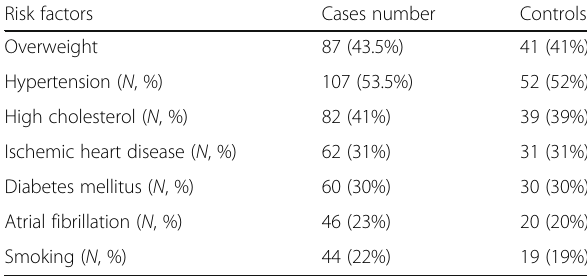
Table 1 vascular risk factors among stroke and control group Risk factors Cases number Controls